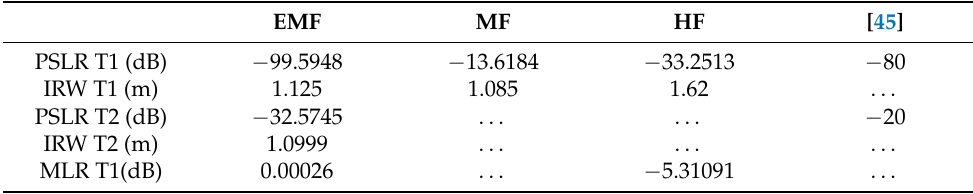
Table 3. PSLR comparison between EMF, MF, and HF in [45].